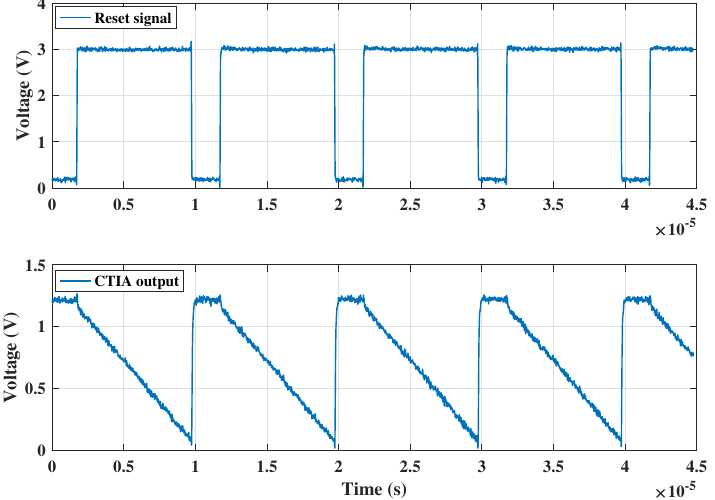
Figure 7. Typical CTIA operation: Reset signal and CTIA output voltage